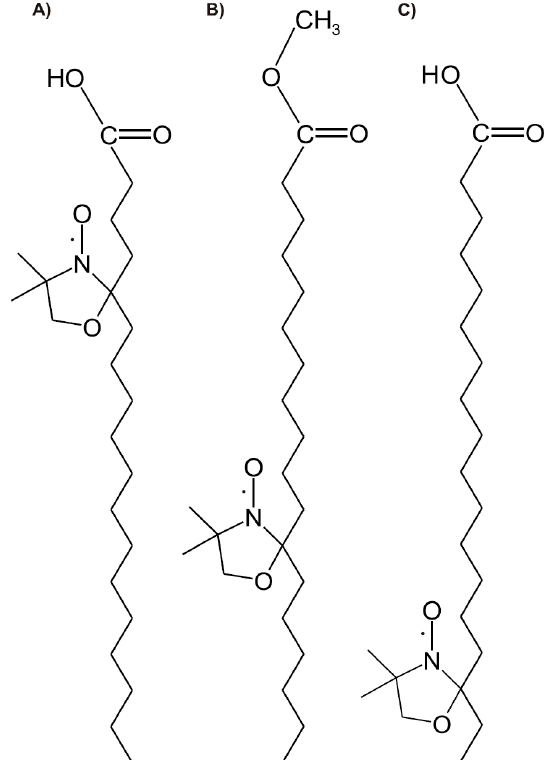
Figure 1. The structure of three derivatives of stearic acid applied in this study spin-labelled using an oxazolidine ring bearing a nitroxyl group: ( A ) 5-doxyl-stearic acid (5-DS), ( B ) 12-doxyl-stearic acid methyl ester (Met-12-DS), and ( C ) 16-doxyl-stearic acid (16-DS).